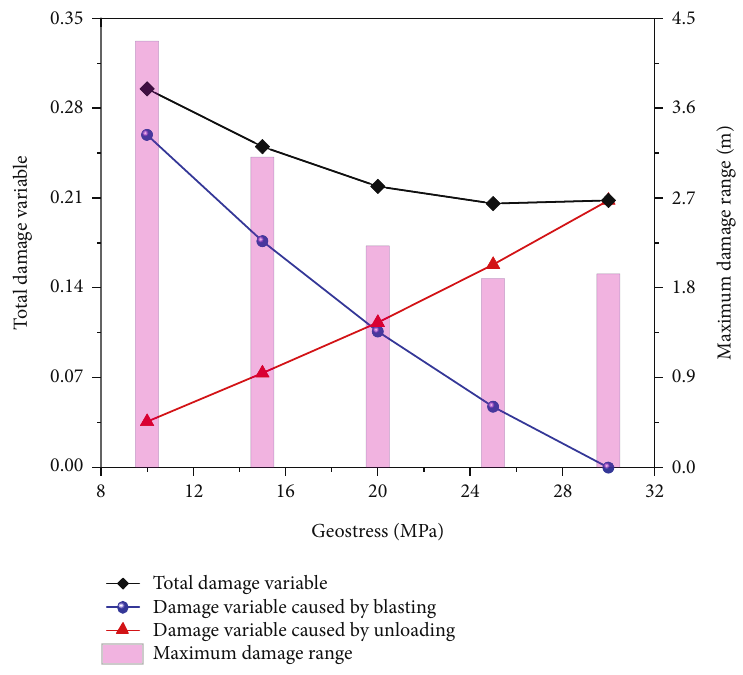
Figure 11: Damage of surrounding rock after excavation in di ff erent